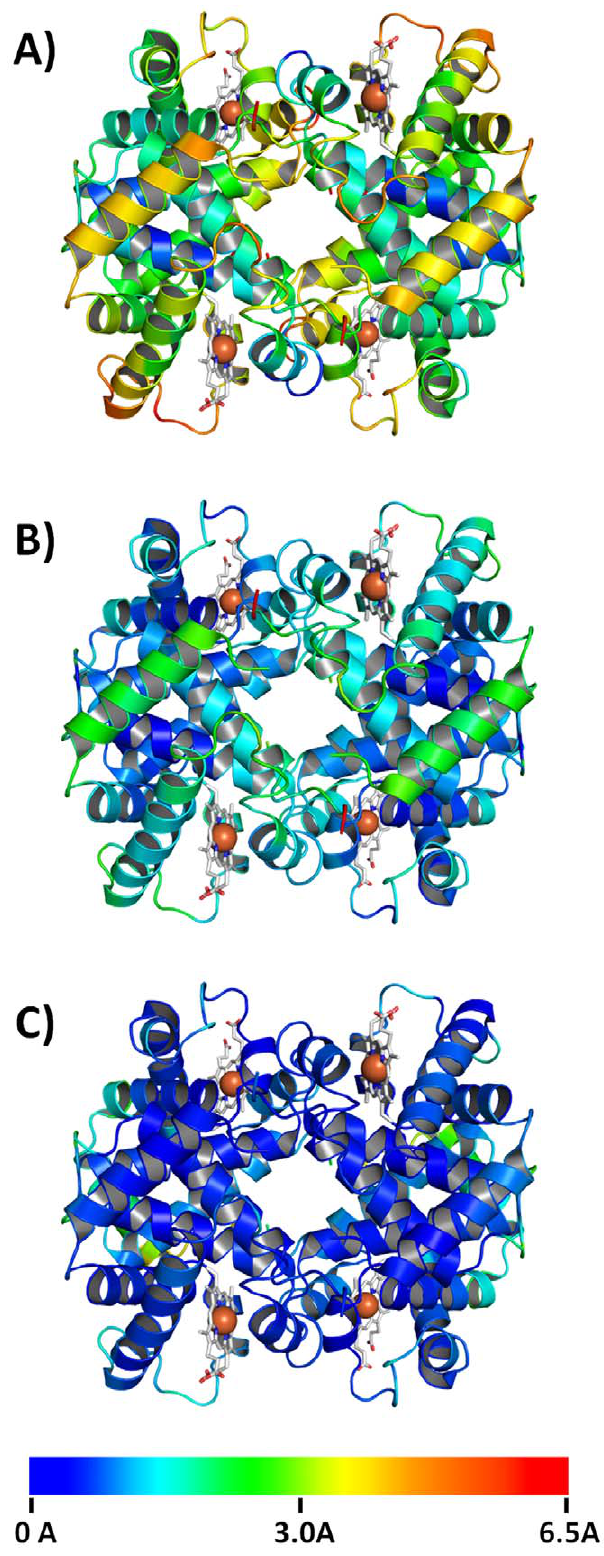
Figure 1. Conformational state of guinea pig hemoglobin. The structure of guinea pig hemoglobin (PDB-code: 3HYU) was superim- posed with the structures of three conformational states of human hemoglobin by their C a -atoms. The guinea pig hemoglobin structure